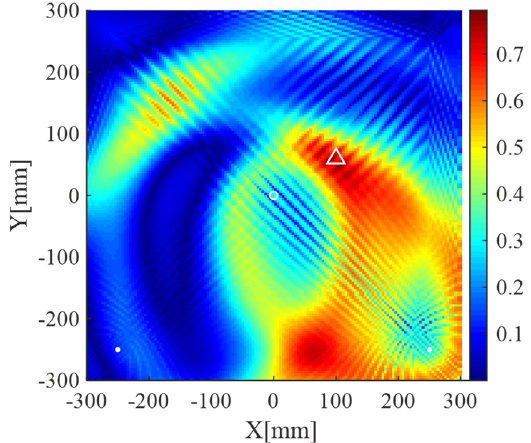
Figure 14. The images generated by the reciprocals of weights, i.e., px m = 1/ w m , using data from two receivers. White dots denote locations of PZT receivers, the white circle denotes the location of the excitation source, and the white triangle denotes the location of the scatterer.